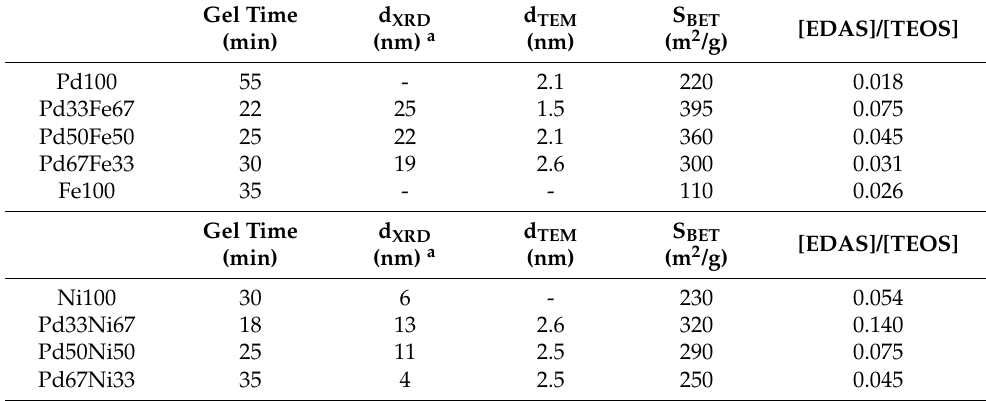
Table 2. Physico-chemical properties of samples Pd-Fe/SiO 2 and Pd-Ni/SiO 2